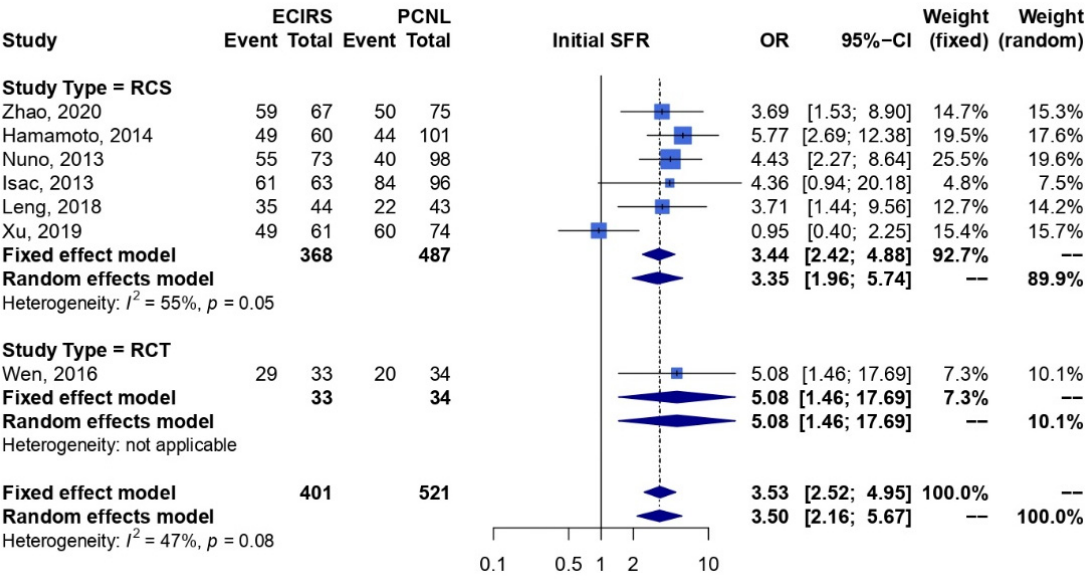
Figure A10. Subgroup analysis of outcome regarding initial stone free rate. (RCS: [18-23]; RCT: